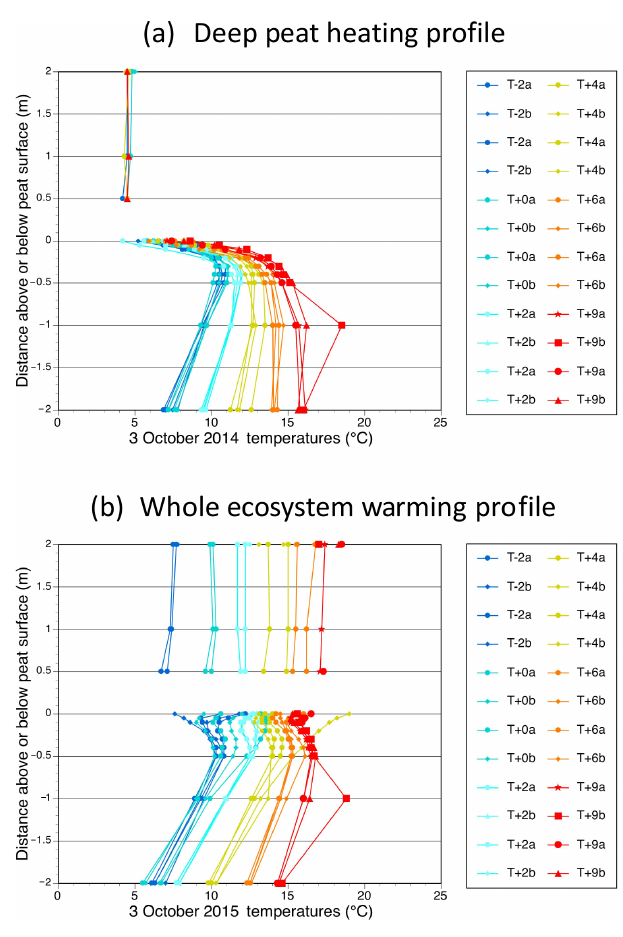
Figure 5. Temperature profiles from + 2m above through − 2m be- low the peat bog hollow surface for (a) 3 October 2014 during deep peat heating and (b) 3 October 2015 under whole-ecosystem warm- ing. Air temperatures are the daily mean and soil temperatures are the value recorded at noon. Colors in the figure legend show data for unchambered ambient ( T − 2 x ), no-energy-added control ( T + 0 x ) and warmed plots: + 2.25( T + 2 x ), + 4.5( T + 4 x ), + 6.75( T + 6 x ) and + 9( T + 9 x ) ◦ C, where x is either the a or the b series temperature zone within the